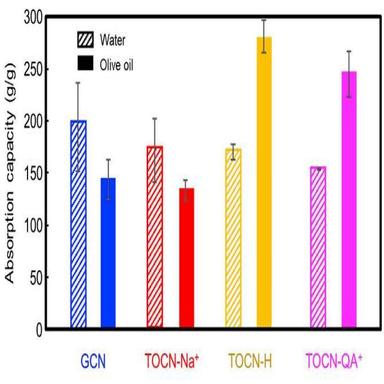
Water and olive oil absorption capacities of cryogels GCN, TOCN-Na+, TOCN-H and TOCN-QA+.